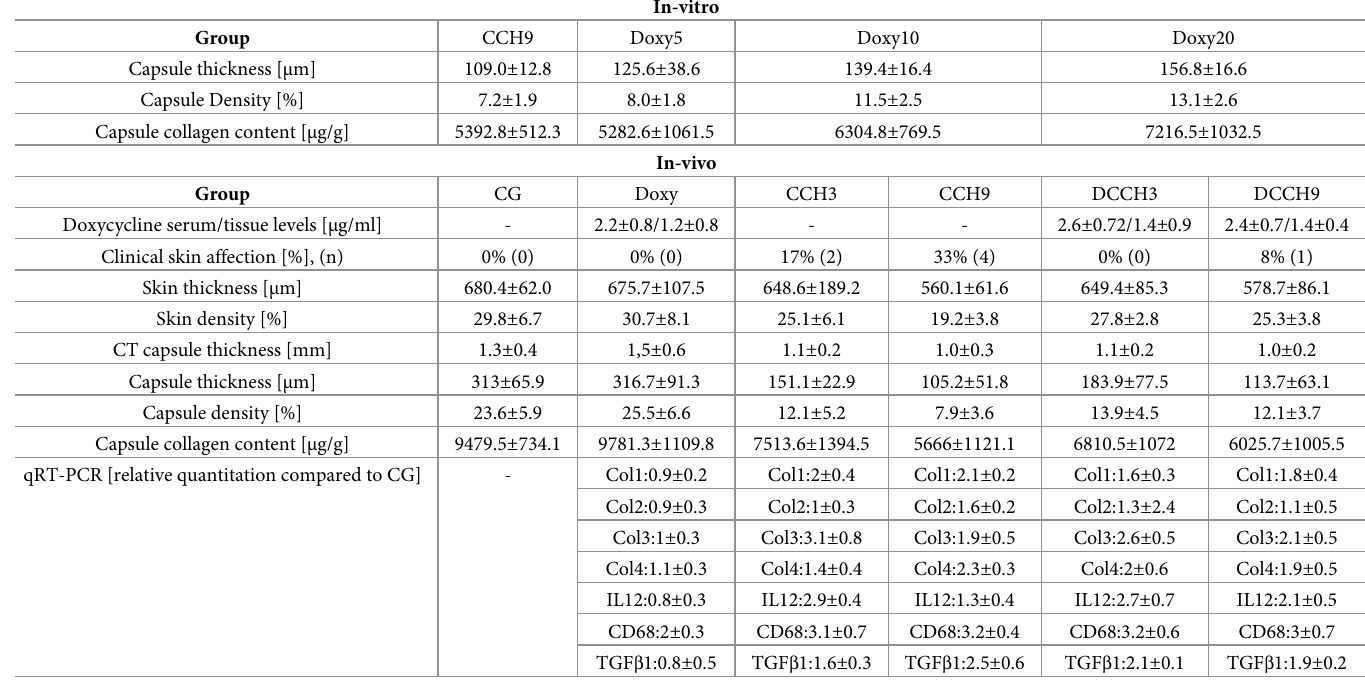
Table 2. Summary of results of all outcome parameters for all groups. Units are given in the first column. Results are given as mean ± standard deviation. For qRT-PCR, Col = Collagen.